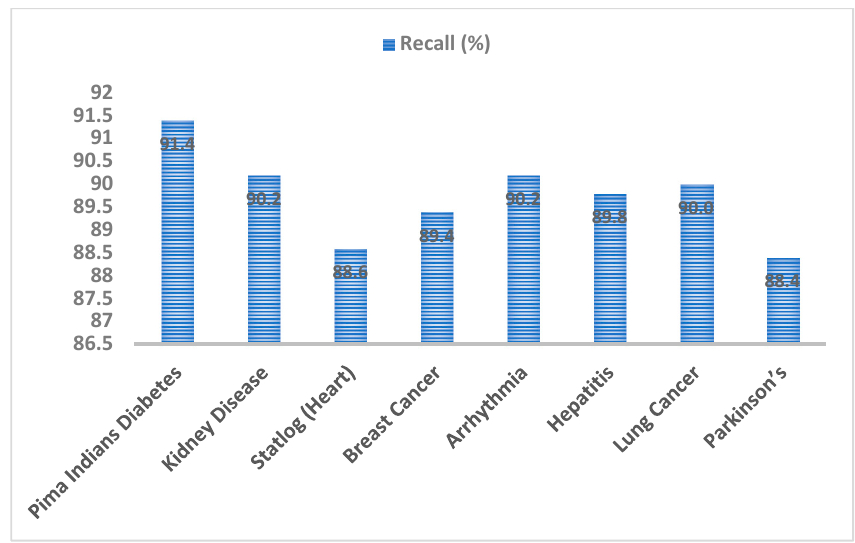
Figure 14. Recall analysis of EAGA-MLP model over different chronic disease datasets.